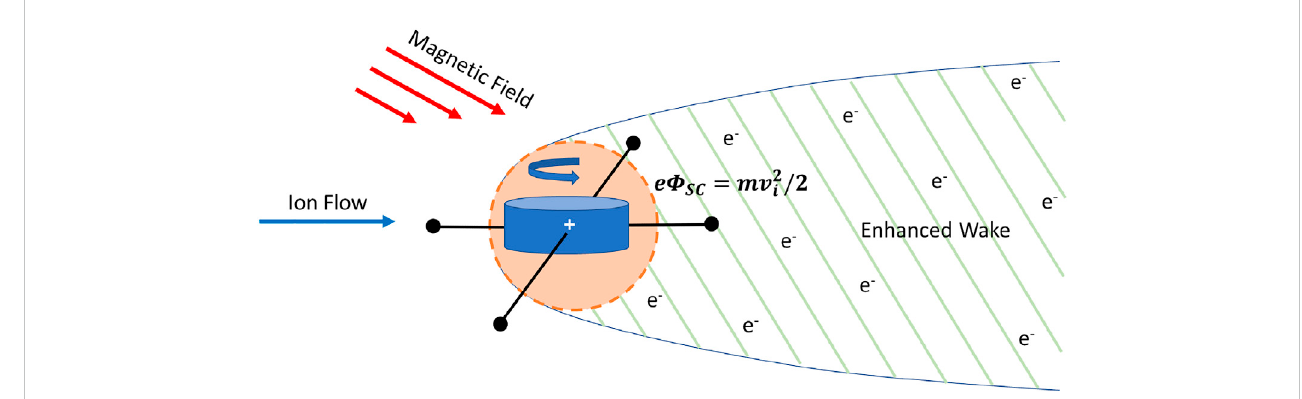
FIGURE 4 Schematic of the enhanced wake behind a positively charged spacecraft. The dashed circle illustrates the equipotential of the spacecraft electrostatic fi eld where e Φ SC (cid:2) mv 2 i / 2 .